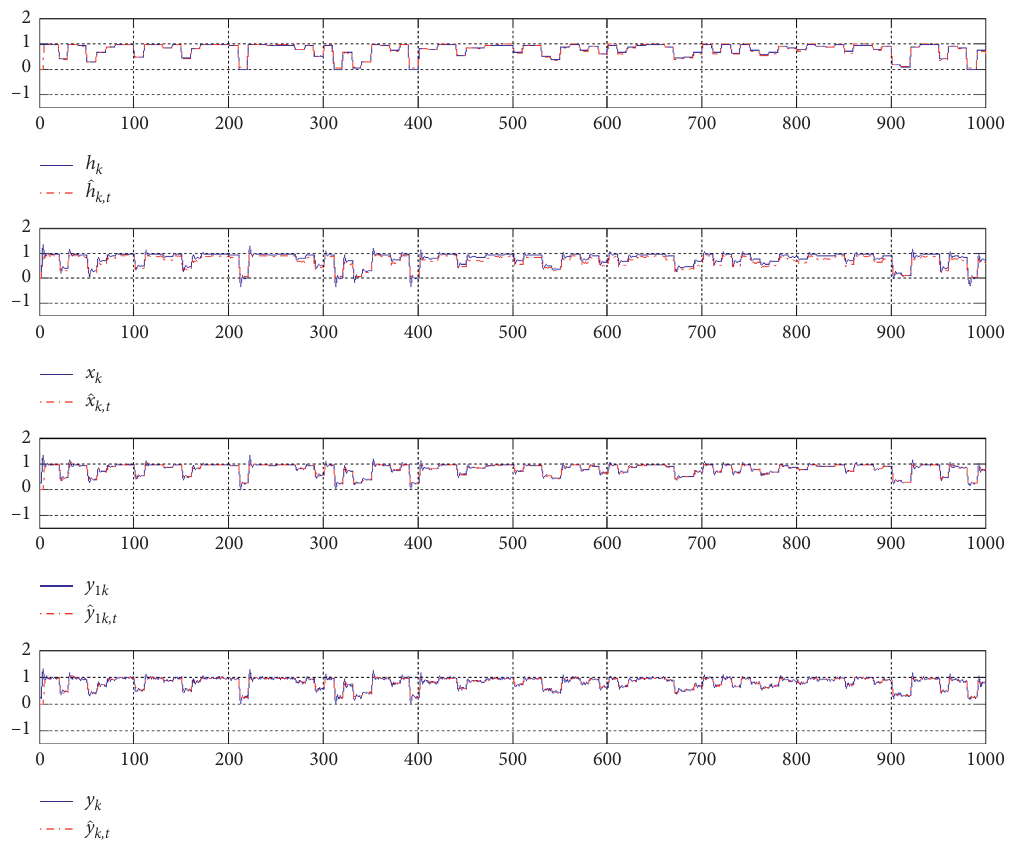
Figure 4: Estimation results of the FSOEAHW model using IBPG for the first 1000 examples.